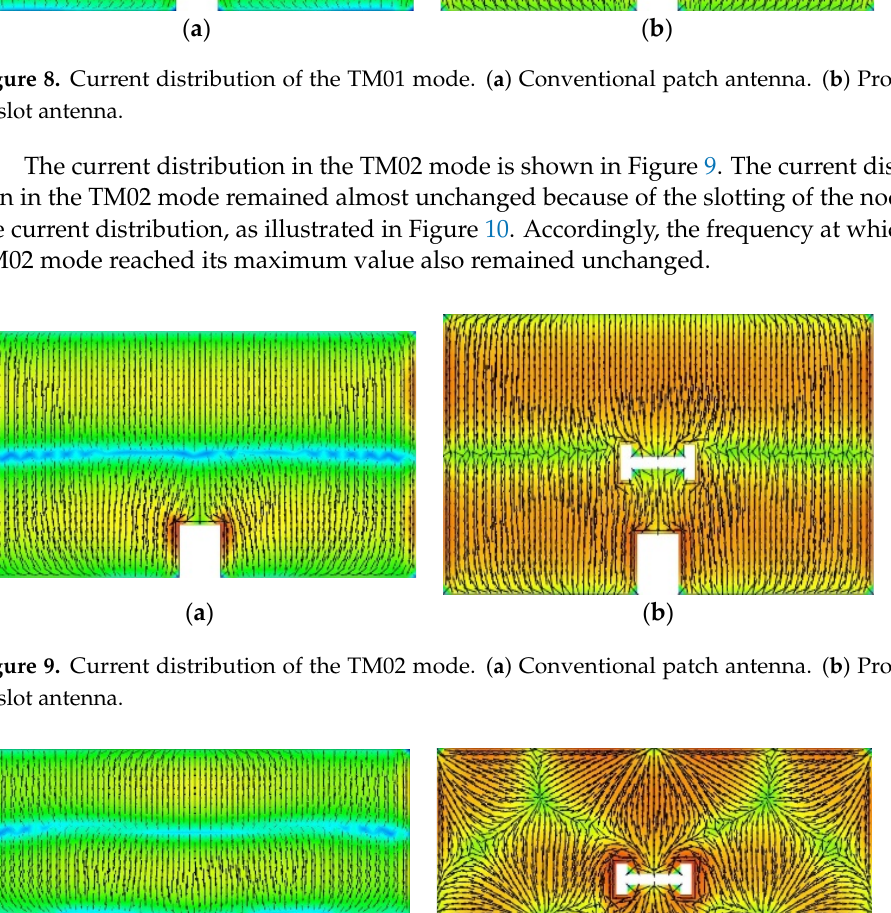
Figure 10. Current distribution of the TM03 mode. ( a ) Conventional patch antenna. ( b ) Proposed H-slot antenna.